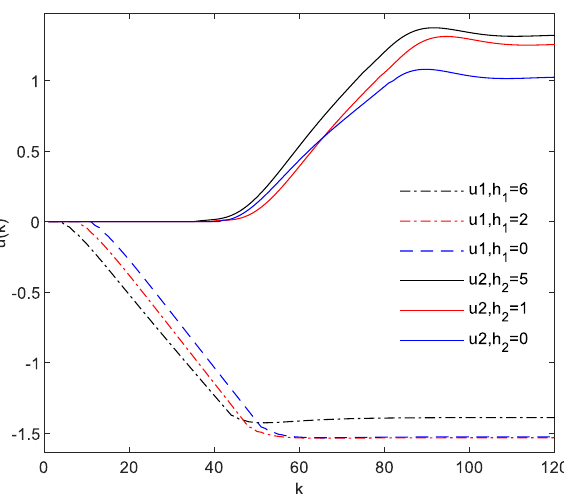
Figure 6. The control input of System (1) with θ 1 = 1.